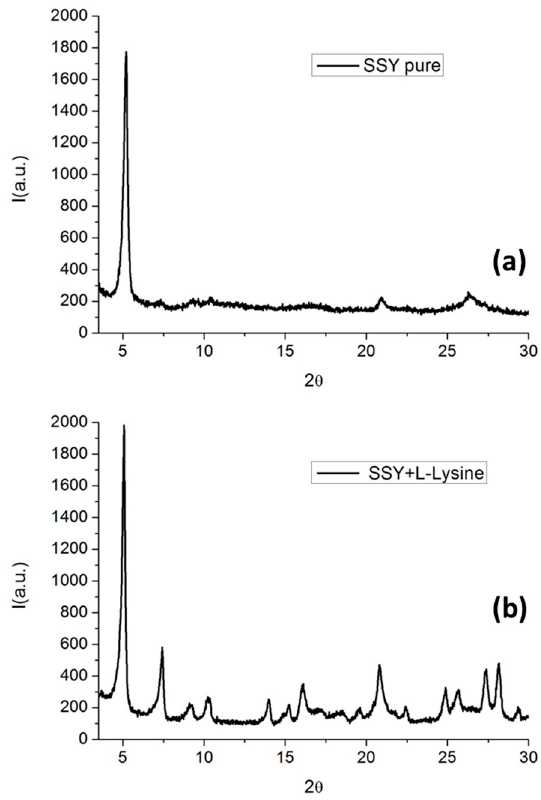
Figure 20. XRD pattern of ( a ) pure SSY and ( b ) SSY doped with L-lysine.